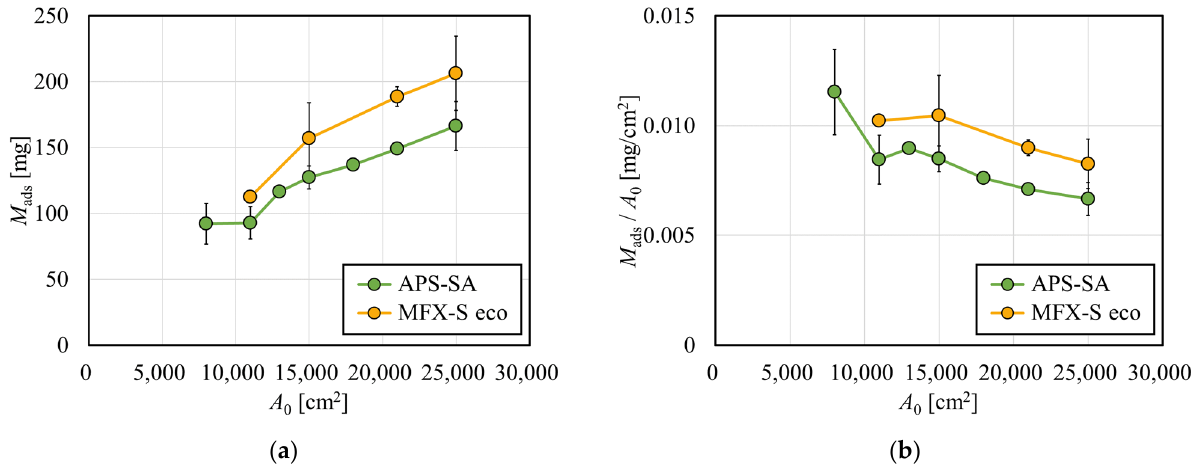
Figure 2. Effect of the arithmetic surface area ( A 0 ) on ( a ) the amount of albumin adsorbed by test modules ( M ads ) and ( b ) the amount of albumin adsorbed per unit surface area of albumin (n = 3). The amount of albumin adsorbed by the membrane was divided by A 0 is shown in